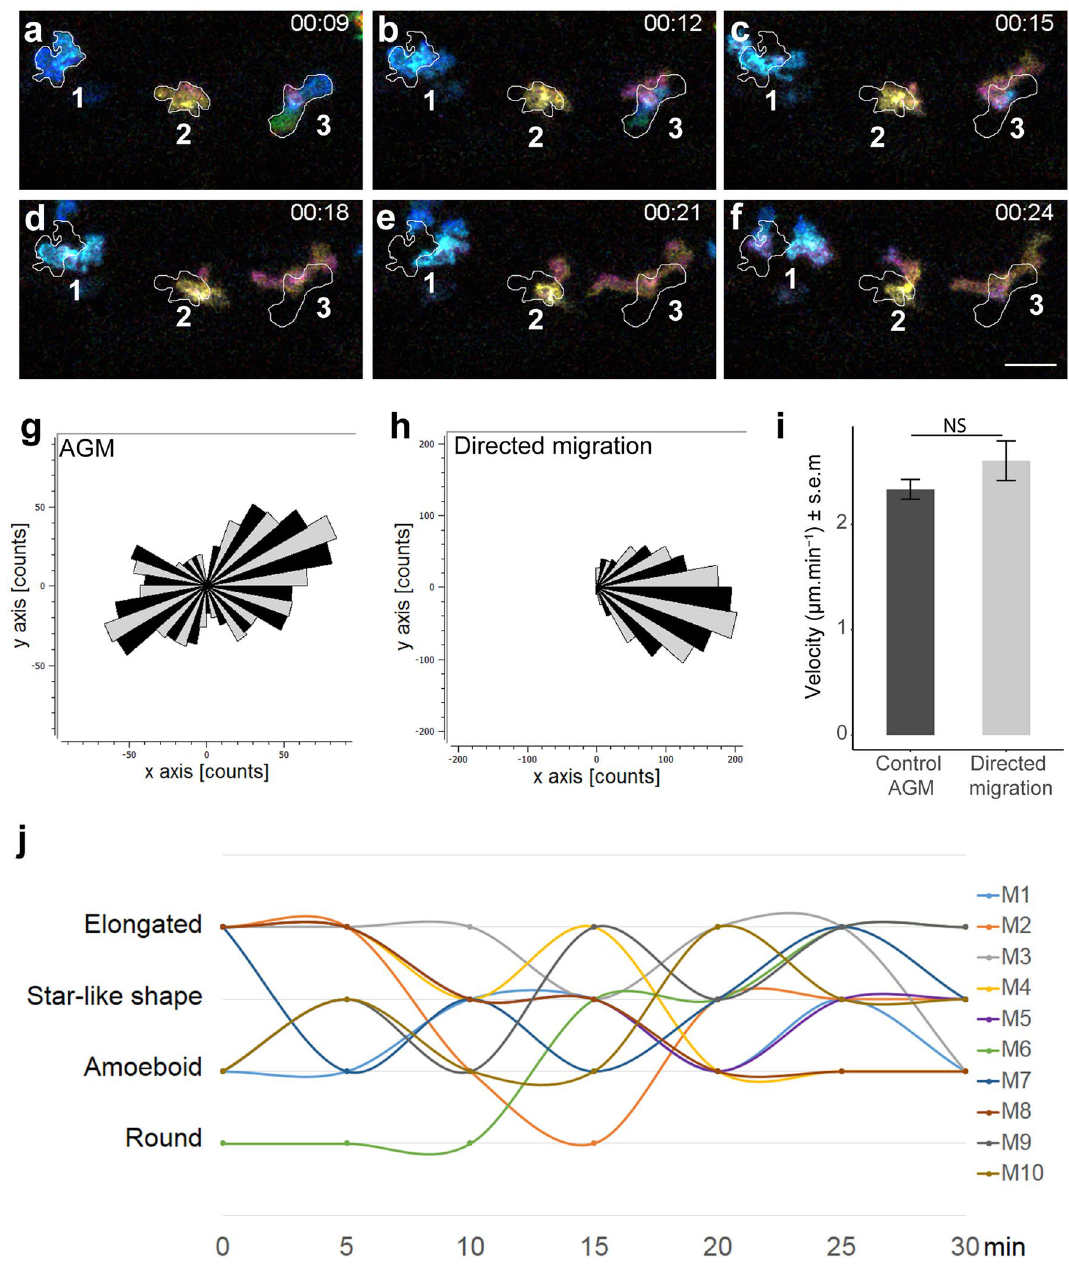
Figure 2. Macrophages in the AGM migrate in the mesenchymal way and undergo dynamic transition between different shapes over time. ( a–f ) Selected images from Video 1 illustrate the macrophage migration and shape transformation over time. Numbers point to individual macrophages. Time code is expressed in hours and minutes. White outlines on panel ( b – f ) indicate the shape and position of macrophages from panel ( a ) (9th minute). ( g , h ) Rose plot diagrams show the directionality of macrophage migration in the AGM compared to the oriented migration of macrophages in the tail region after tail fin cut injury. A diagram represents the single counts of the position of each macrophage in the selected area (black and grey sectors of angle π/18) every minute over 60 min with a (x,y 0,0) starting point. n = 23 macrophages for the control and n = 27 for directed migration. ( i ) Bar plot show the comparable velocity between macrophages in the AGM and macrophages migrating toward a cut in the tail region. NS not significant; bar plot was generated in R using ggplot2 package. ( j ) Graph showing the shape evolution of individual macrophages during a 30 min course with 5 min interval measurements. Every line represents a single macrophage (n = 10). See also Video 1. Scale bar ( a – f ) 30 µm. See also Supplementary Figure